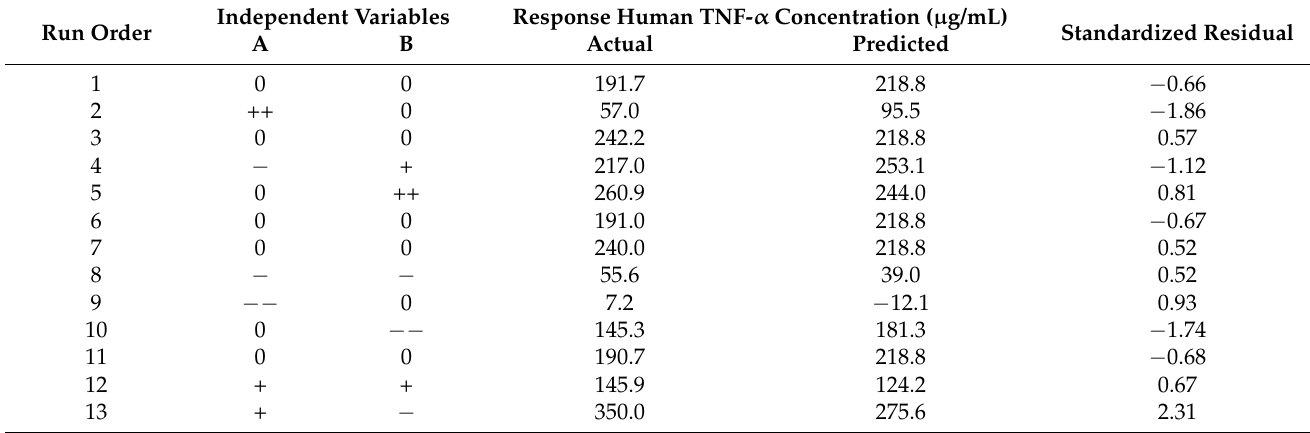
Table 5. Central composite matrix with experimental and predicted results of cell-free synthesized human TNF- α